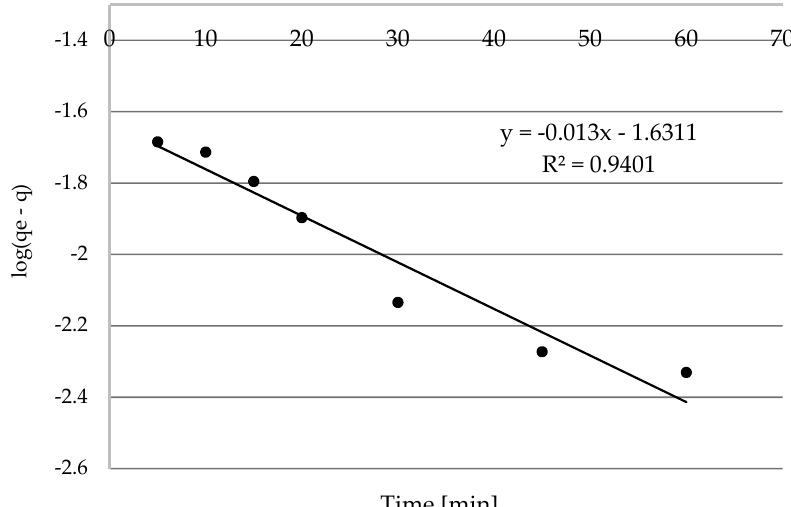
Figure 11. The pseudo first-order kinetic plot for the adsorption of Ni(II).